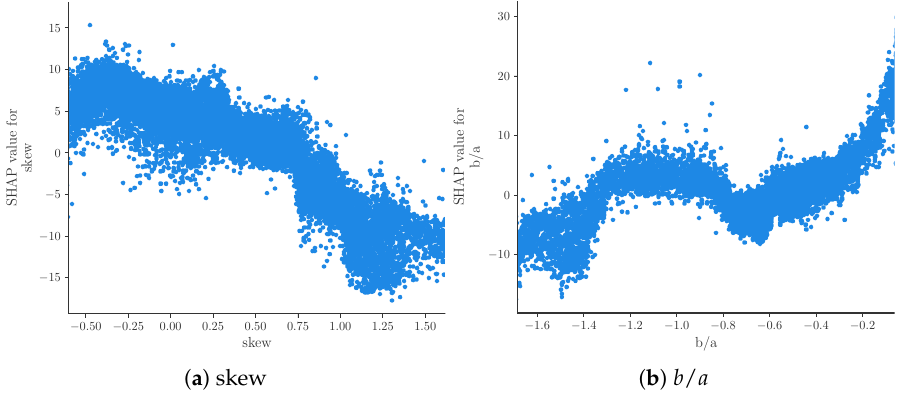
Figure 4. Dependence plot for features skew and b / a showing the relationship of the value of the feature and its SHAP value for all samples. All samples with feature values in the first and 99th percentile are